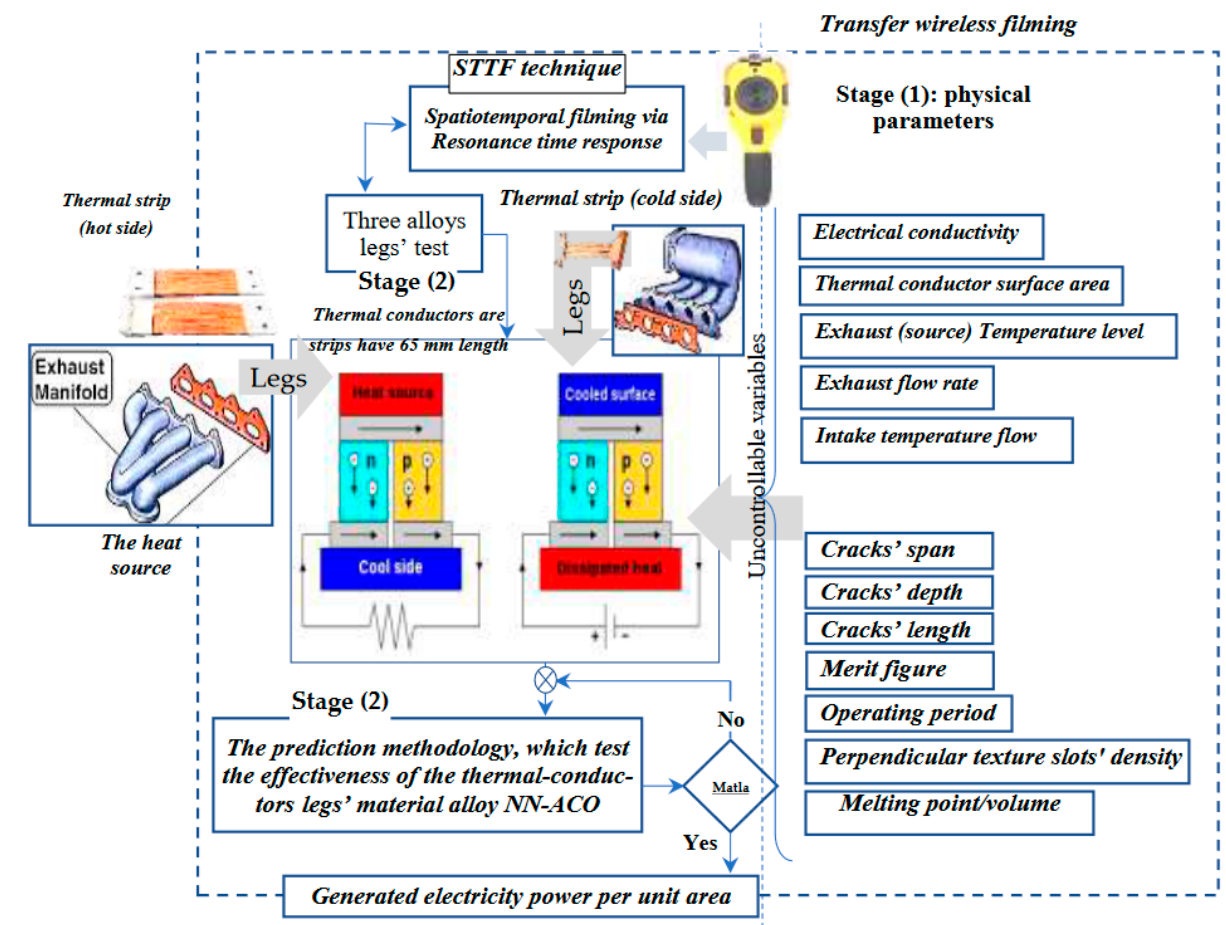
Figure 3. The digital twin simulator architecture.